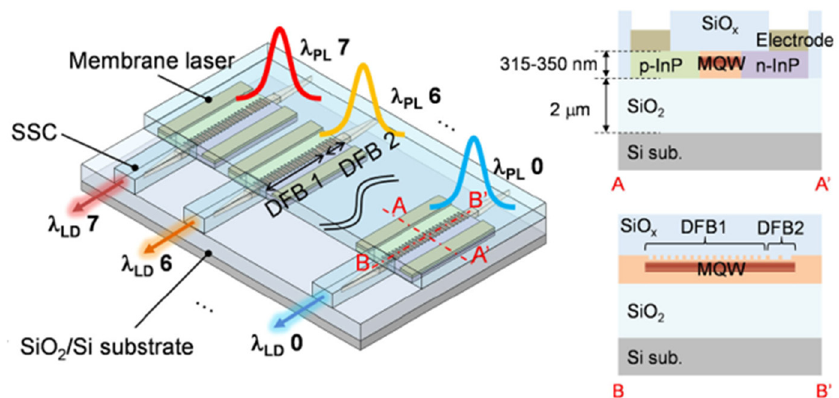
Figure 18. Schematic diagram of eight-channel laser array and membrane laser cross–sections. The output light for each channel was coupled with single–mode fiber by butt–coupling the facets of the high–numerical–aperture fiber and spot-size converter (SSC). Reprinted with permission from ref. [76] © The Optical Society. Copyright 2020